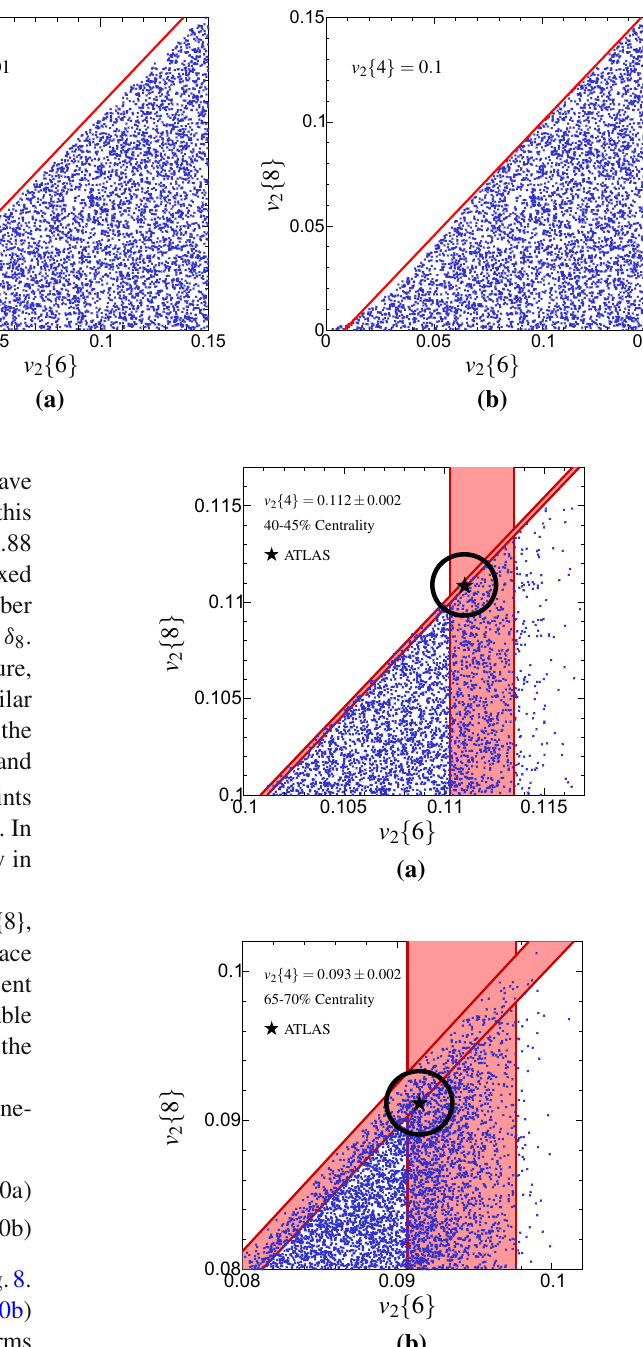
Fig. 8 Combining the constraints Δ 2 { 4 , 6 } (cid:2) 0 and 11 Δ 2 { 6 , 8 } − Δ { 4 , 6 } (cid:2) 0 to find the allowed region of v 2 In this case, δ 6 , δ 6 and v 2 { 4 } are not completely fixed. The region is compatible with the ATLAS data reported in Ref. [18]